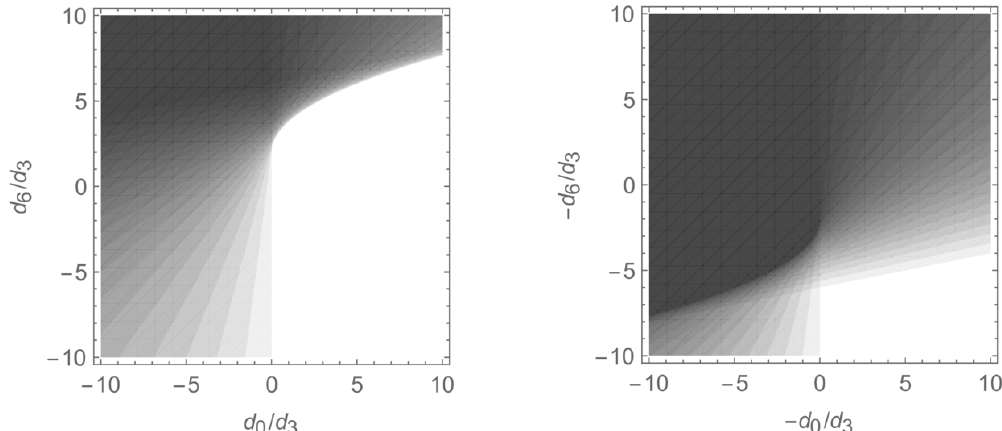
Figure 2 . Constraints on higher-dimension operator coe(cid:14)cients derived from black hole entropy. The shaded regions are excluded, with the gradations corresponding to incremental values of (cid:24) 2 (0 ; 1 = 2). The left and right panels correspond to d 3 > 0 and d 3 < 0, respectively. In either case, d 0 < 0 is forbidden so d 0 > 0 and the WGC is automatically